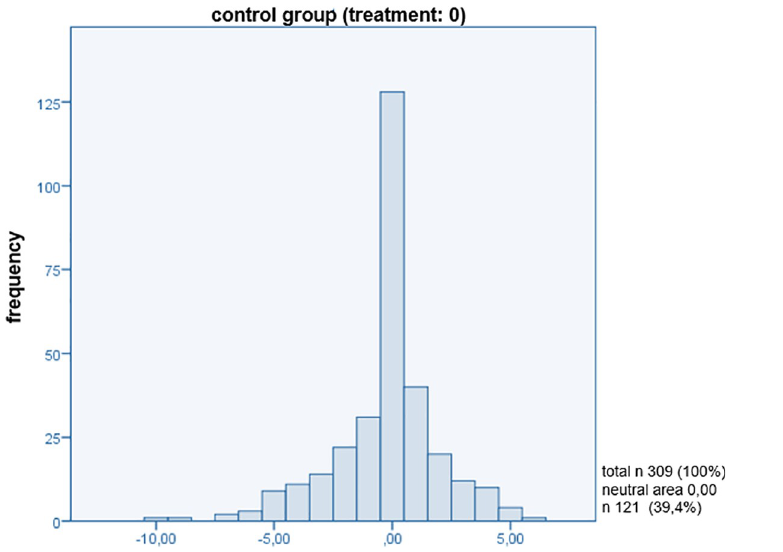
Fig 2. Control group (treatment: